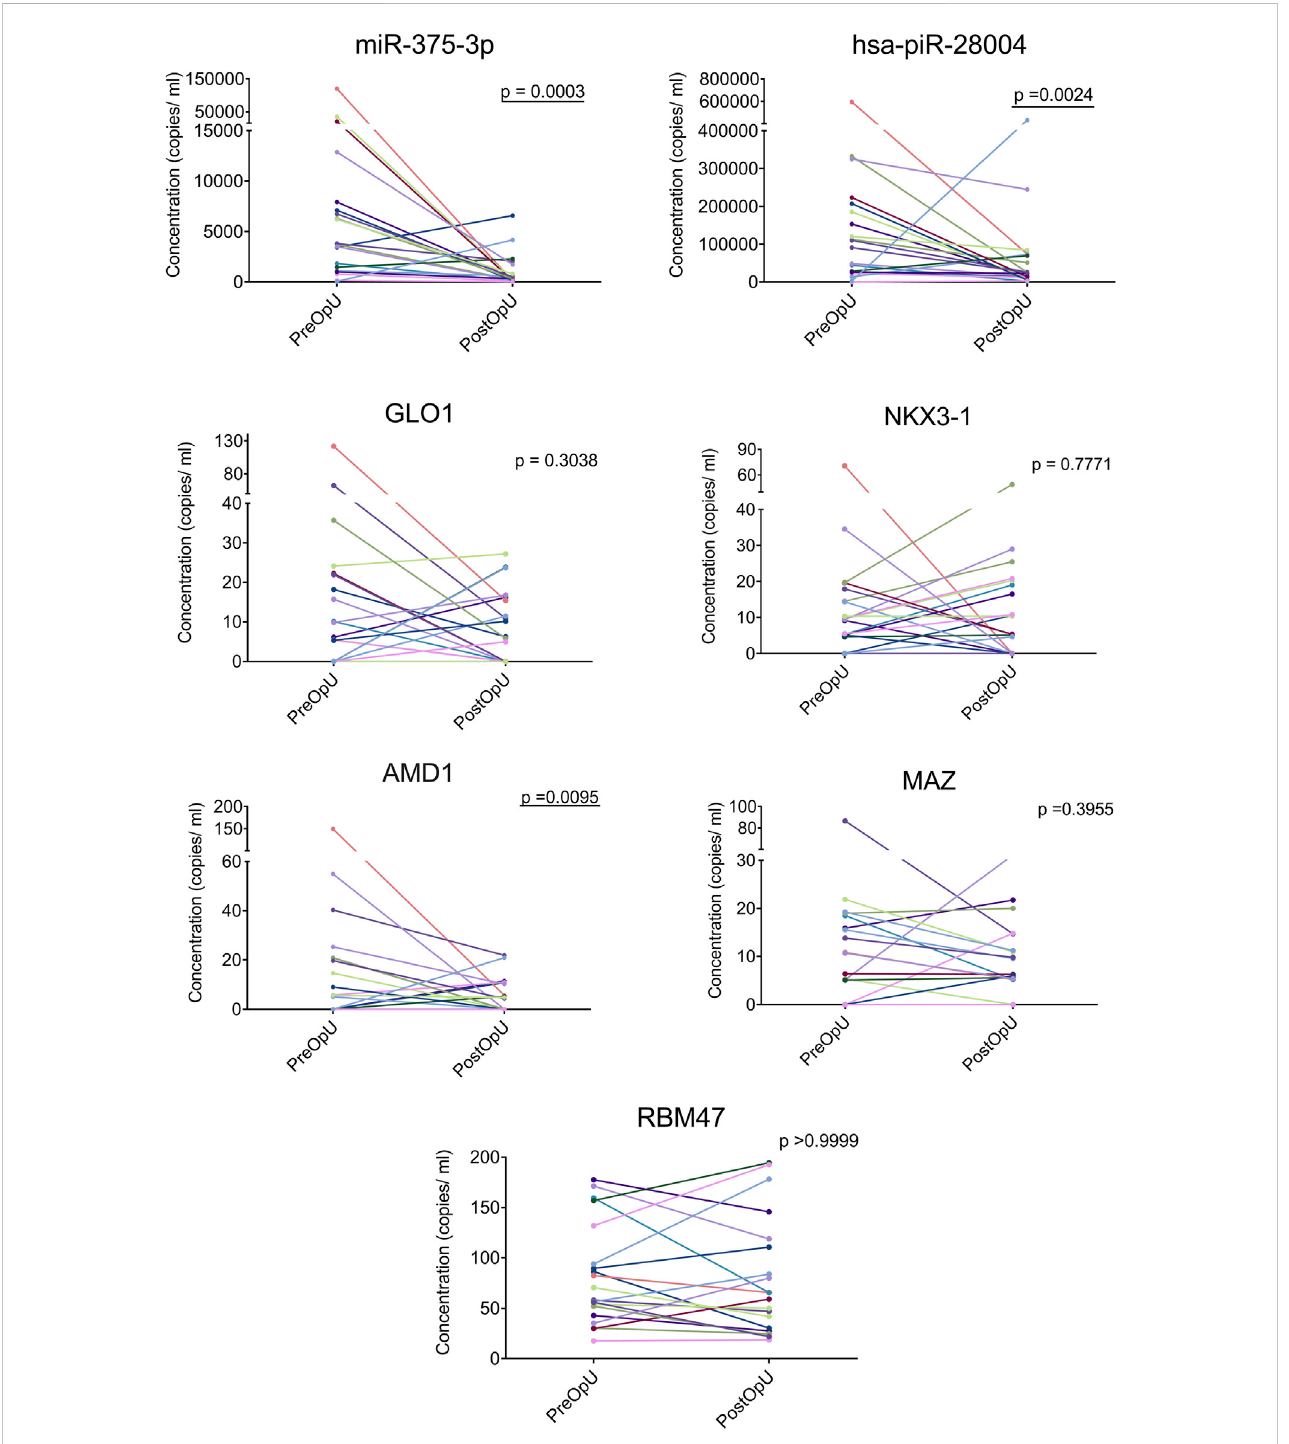
FIGURE 6 Validation of selected biomarker candidates in urinary EVs from an independent cohort of 20 PC patients by RT-ddPCR. Paired dot plots show the copy number ofRNAbiomarkerspermlofurine collected beforeandafter radicalprostatectomy in20PC patients. Wilcoxonmatched-paired signedrank testwas used to assess the statistical signi fi cance of the differences between groups. p -value < 0.05 was considered signi fi